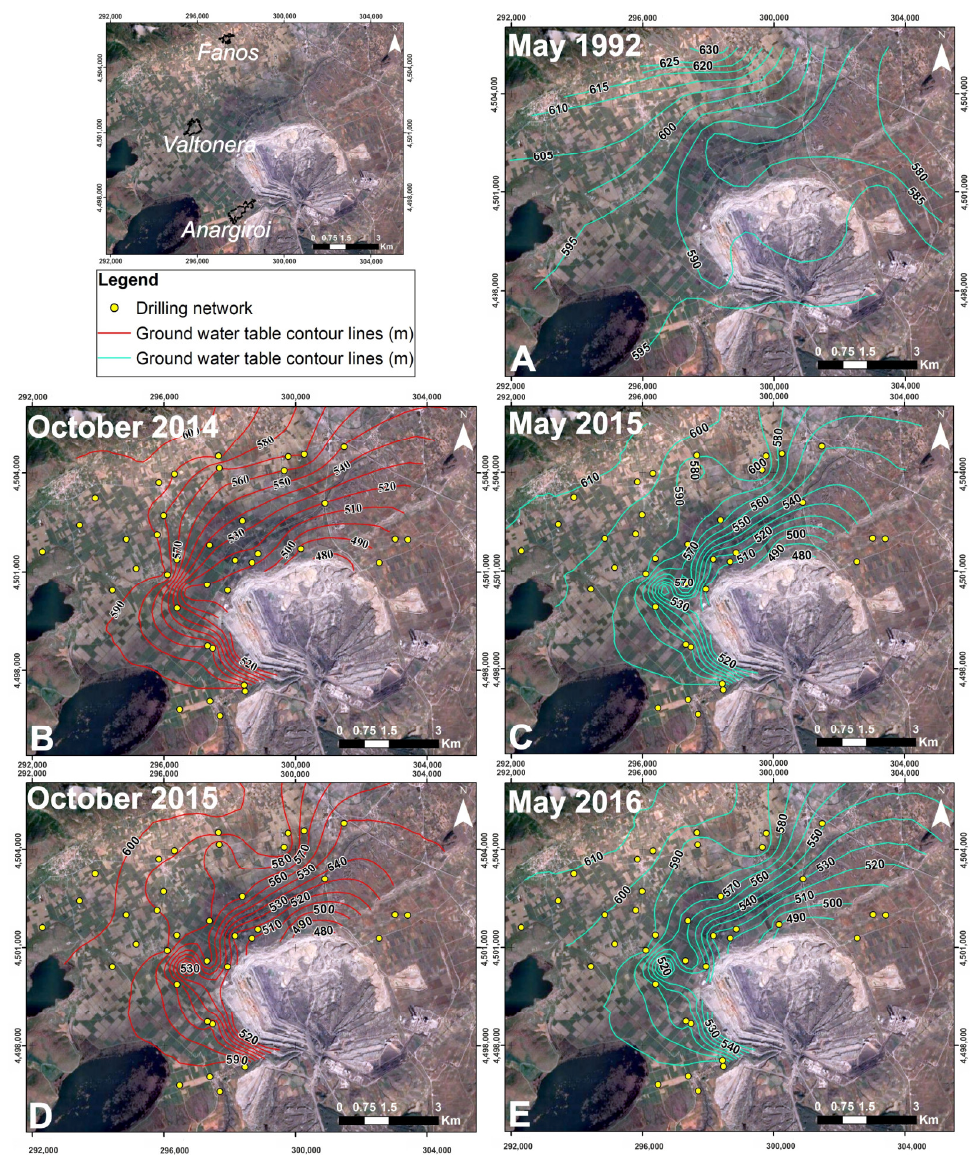
Figure 2. Ground water table contour lines based on the measurements carried out on: ( A ) May